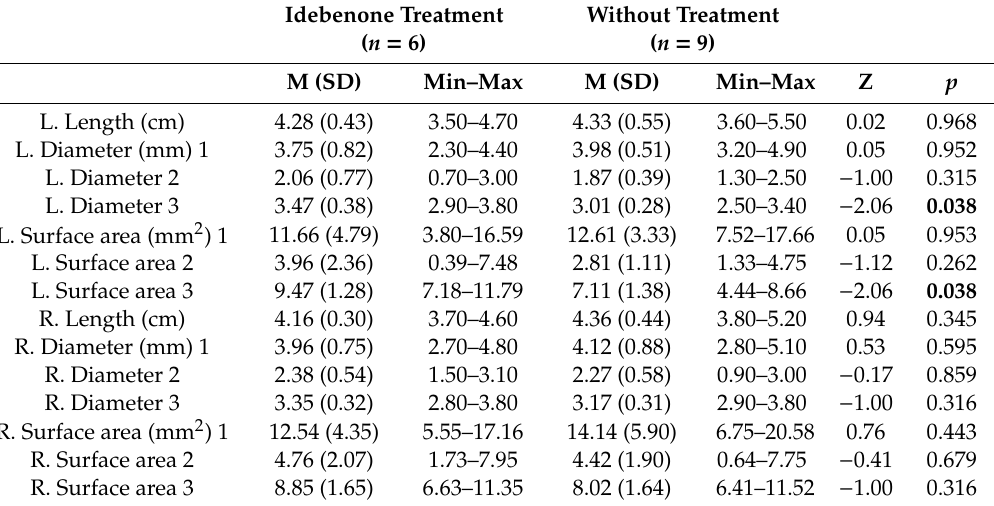
Table 2. Comparison of quantitative nerves parameters in two LHON subgroups created on the basis of Idebenone treatment